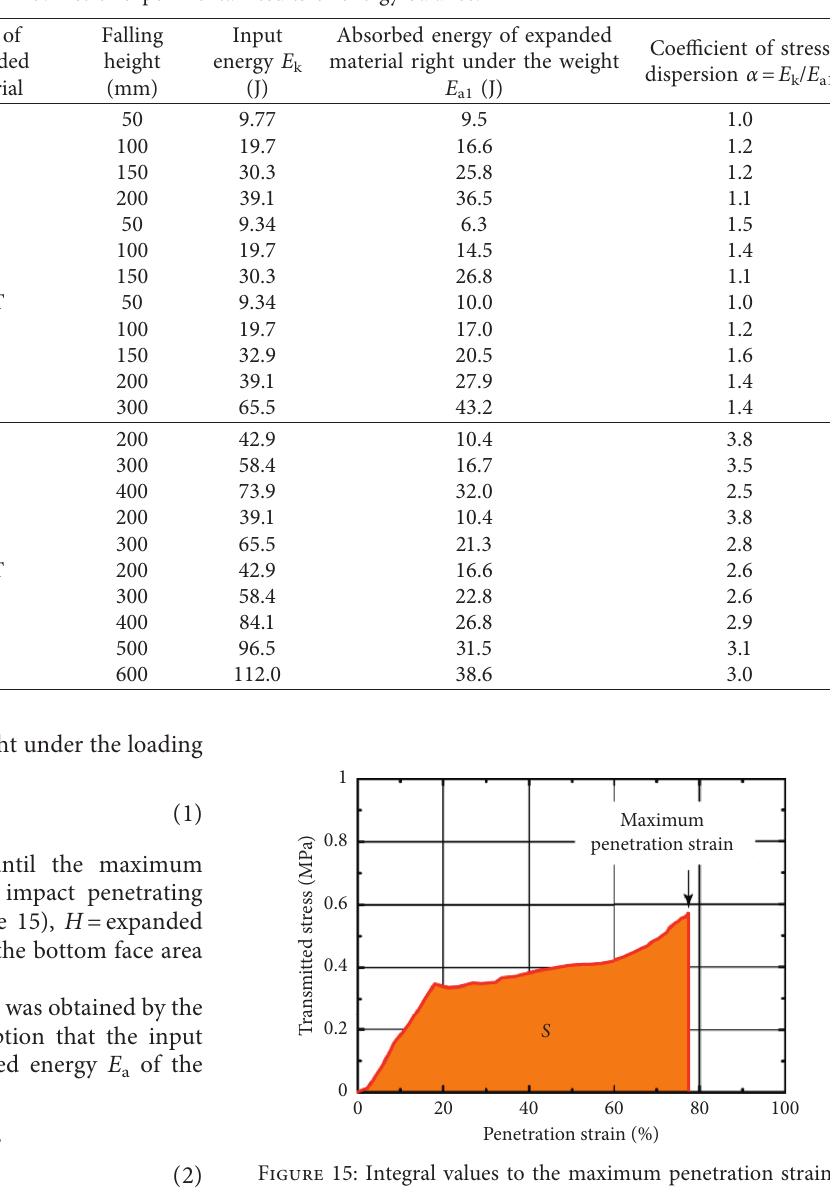
Table 3: List of experimental results of energy balance.